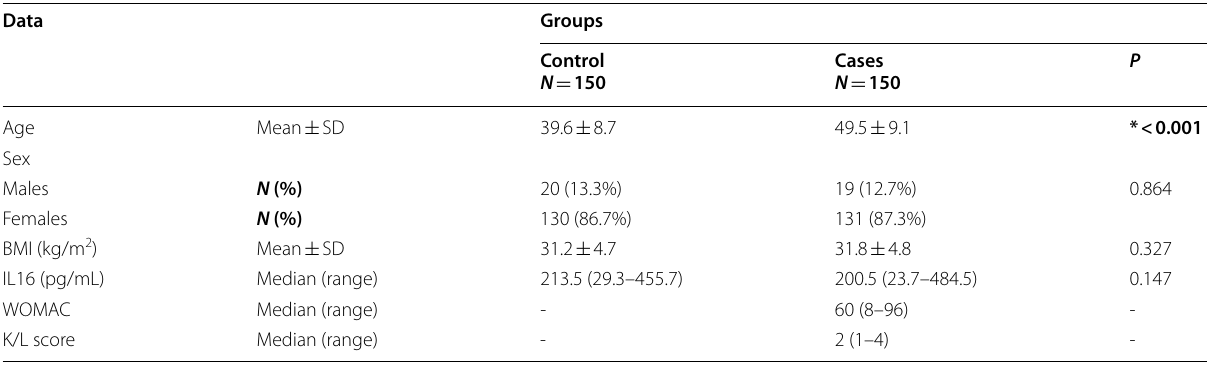
Table 1 Demographic data, IL16, and clinical and radiological features in OA cases and control